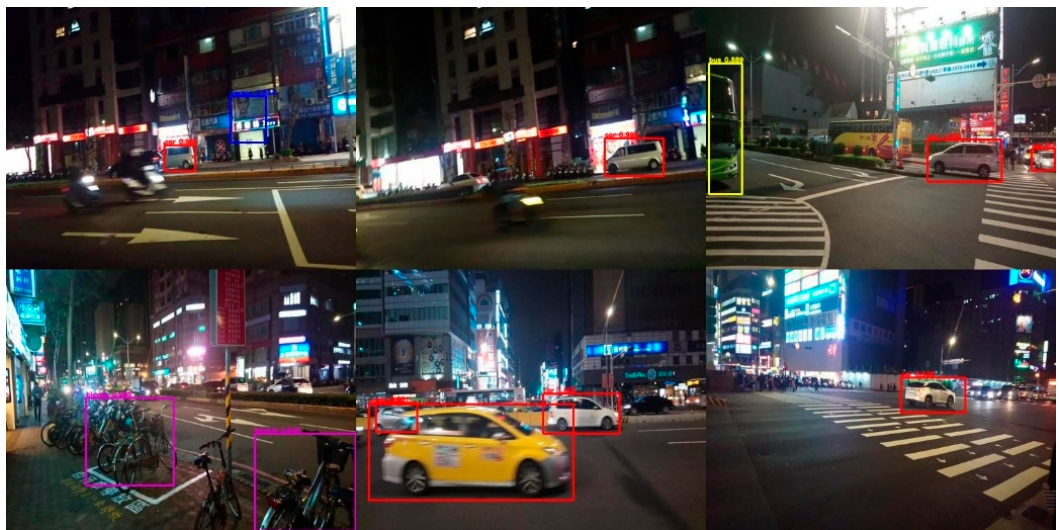
Figure 2. Urban nighttime images processed by the Faster R-CNN [5] with ResNet101 [2] trained using PASCAL VOC 2007 [6].